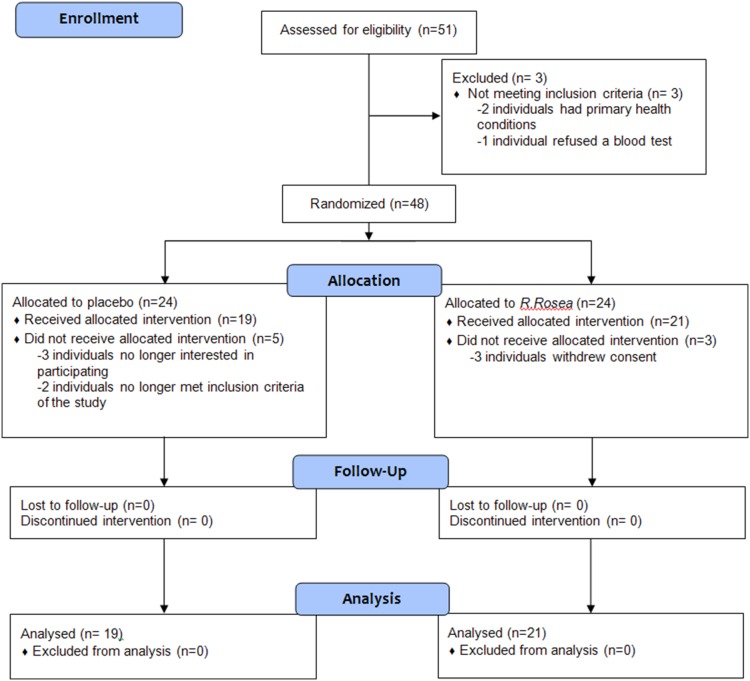
Participant flow.